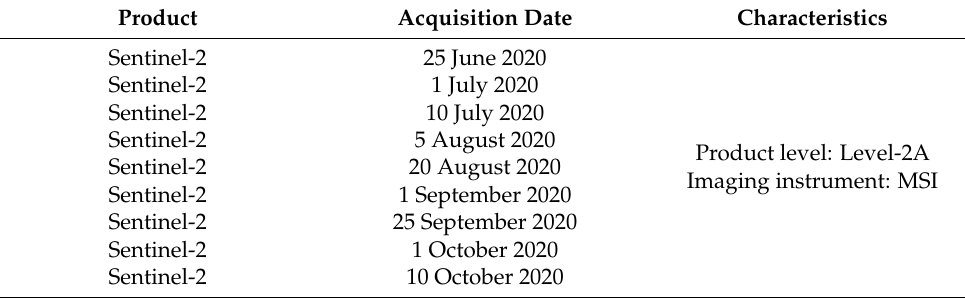
Table 2. Sentinel-2 multispectral